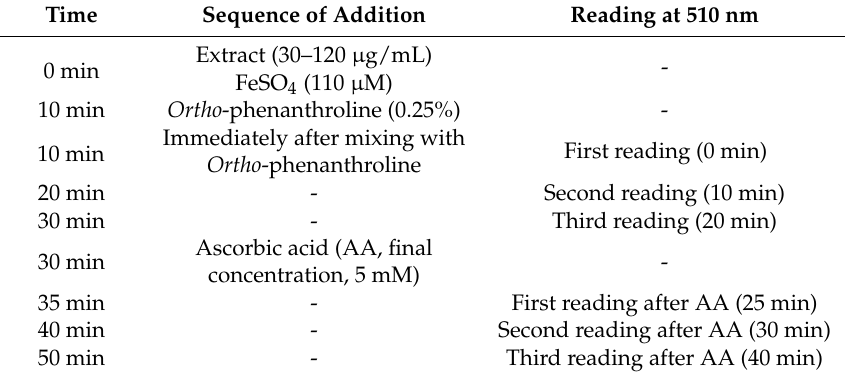
Table 2. Phenolics and flavonoids composition of R. echinus extracts.